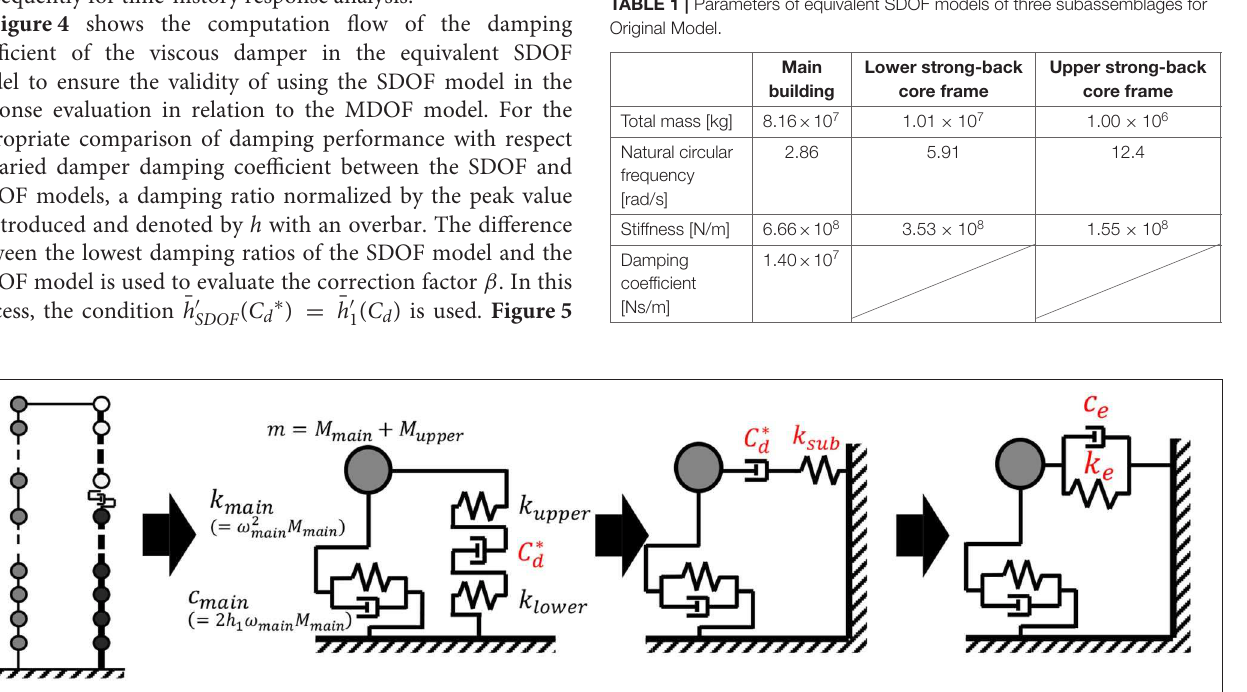
FIGURE 3 | Reduction of MDOF model into equivalent SDOF